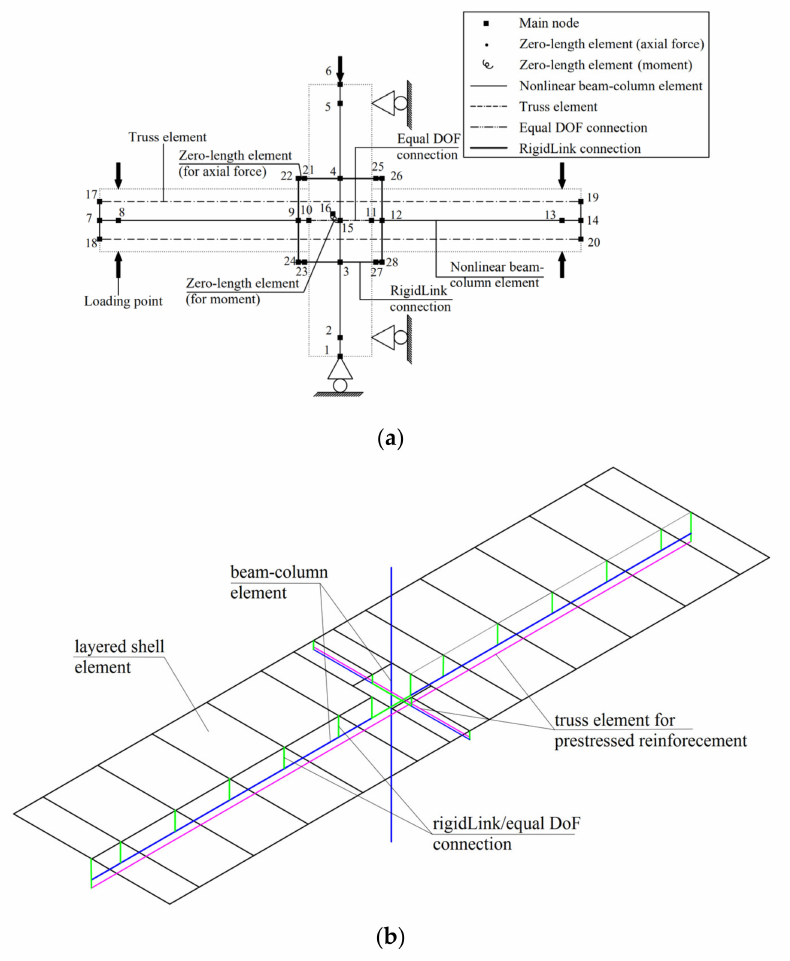
Figure 2. Schematic representation of dry-type precast connections: ( a ) 2D view; ( b ) 3D view. The layered shell element was implemented in OpenSees by Prof. Lu’s group from Tsinghua University in 2015 [22,23], proving the reliability of this element and formulation in simulating reinforced concrete shear wall structures. The walls or slabs can be divided into several layers, indicating concrete material and/or reinforcement material in multiple directions, as shown in Figure 3, to simulate the spatial mechanical behavior of concrete walls or slabs with distributed reinforcement mesh. Therefore, several kinds of material models should be implemented to accurately reflect the mechanism of the dry-type beam– slab